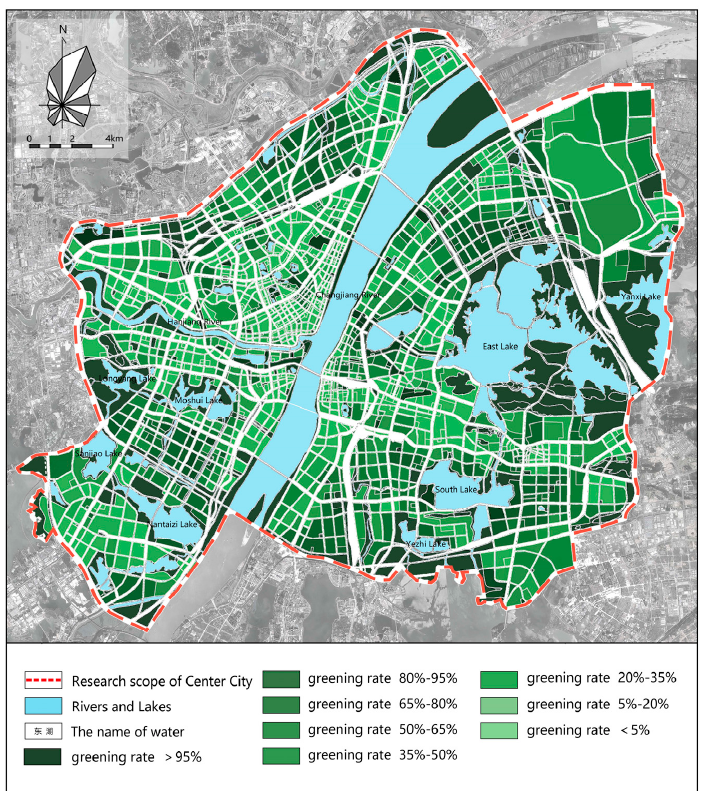
Figure 14. Minimum green coverage and green coverage of downtown Wuhan.